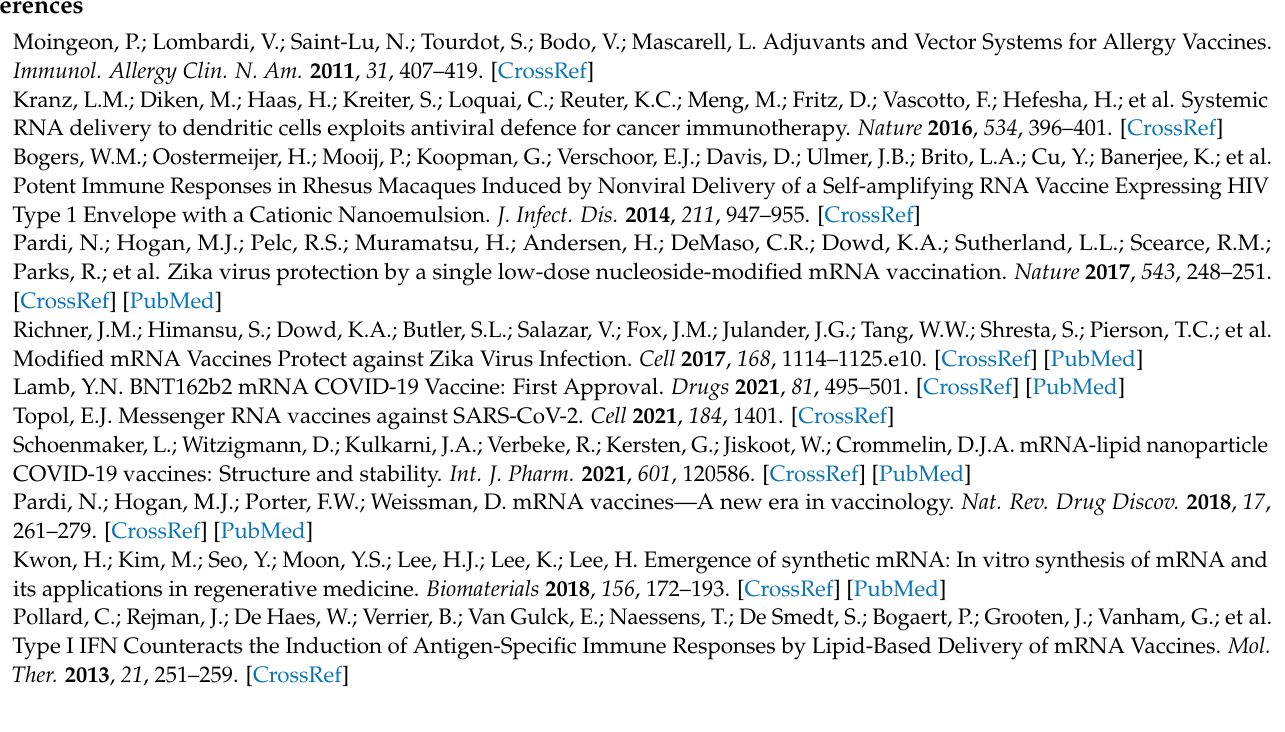
expression in splenic DCs, Figure S6: Correlation between ζ -average and Nluc expression, Figure S7: I-A/I-E expression in splenic DCs after intravenous injection of LNPs examined in screening A and B, Figure S8: Stability of the A-11-LNPs, Figure S9: Examination of dose of the OVA mRNA-loaded A-11-LNPs for therapeutic antitumor experiment, Figure S10: Serum IFN β level after an intravenous injection of OVA mRNA-loaded formulations at a dose of 0.03 mg mRNA/kg, Figure S11: Therapeutic antitumor effect of the A-11-LNPs on high dose conditions, Figure S12: Examination of formation of memory cells, Table S1: Full data of outputs of in vivo experiment in screening A, Table S2: Formula- tion conditions and physicochemical properties of the LNPs examined in screening B, Table S3: Full data of outputs of in vivo experiment in screening